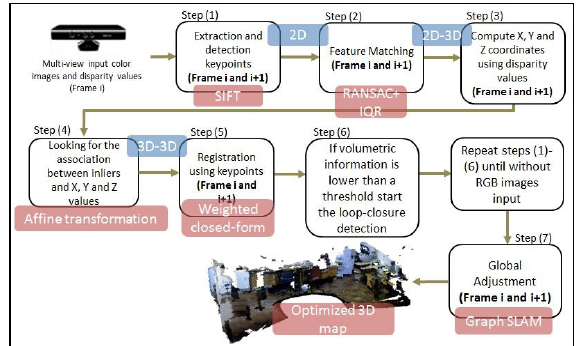
Figure 1. Generic structure of the proposed